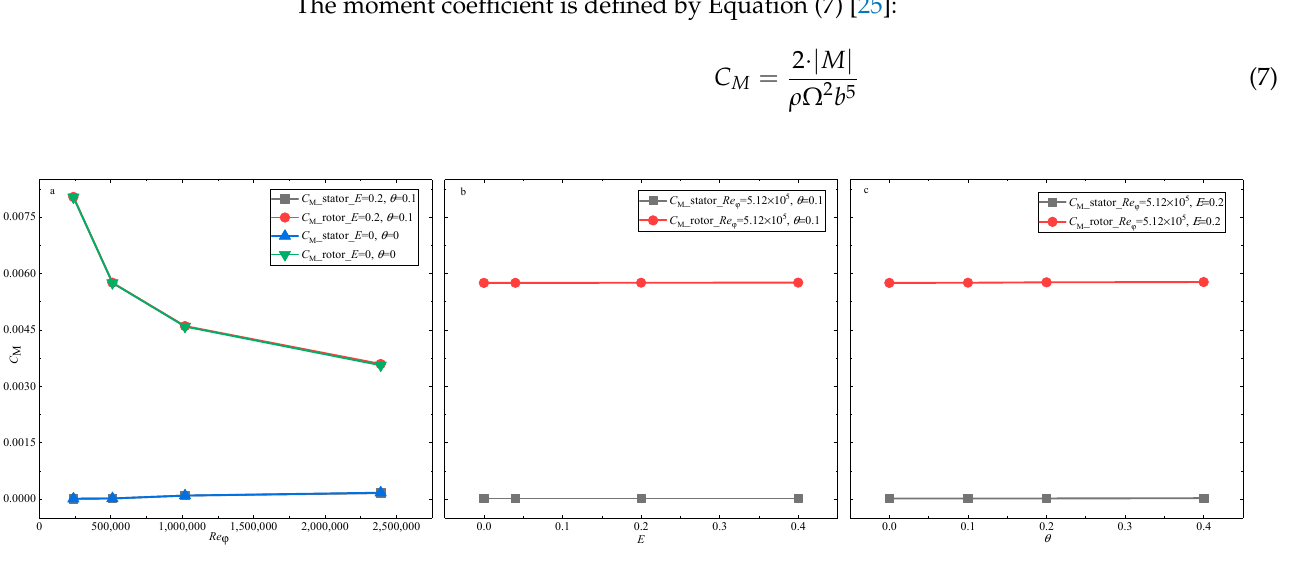
Figure 23. Moment coefficient of rotor and stator on the rotating shaft (z): ( a ) E = 0.2, θ = 0.1; ( b ) Re ϕ = 5.12 × 10 5 , θ = 0.1; ( c ) Re ϕ = 5.12 × 10 5 , E =